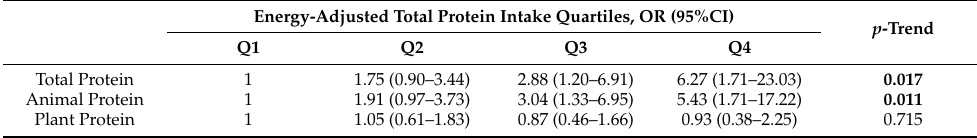
Table 3. The association between maternal protein intake and GDM